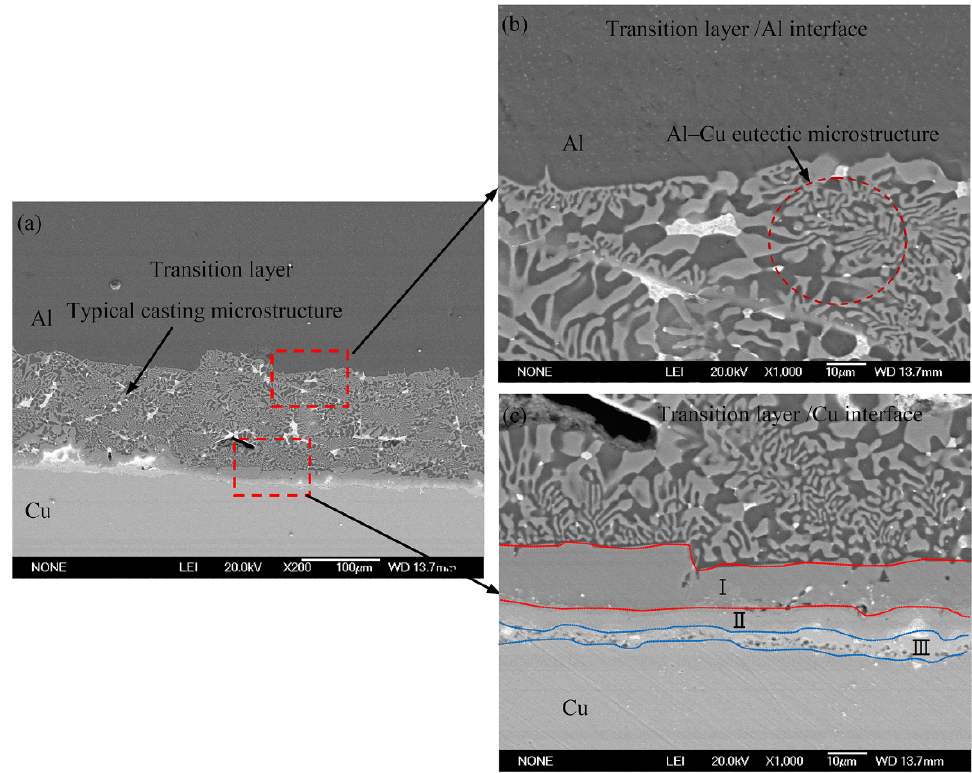
Figure 4. The typical interface morphology of Cu/Al cathode conductive head produced by solid–liquid casting shown as: ( a ) the overall characteristics of the interface, ( b ) the microstructure of the transition layer/Al interface and ( c ) the microstructure of the transition layer/Cu interface.